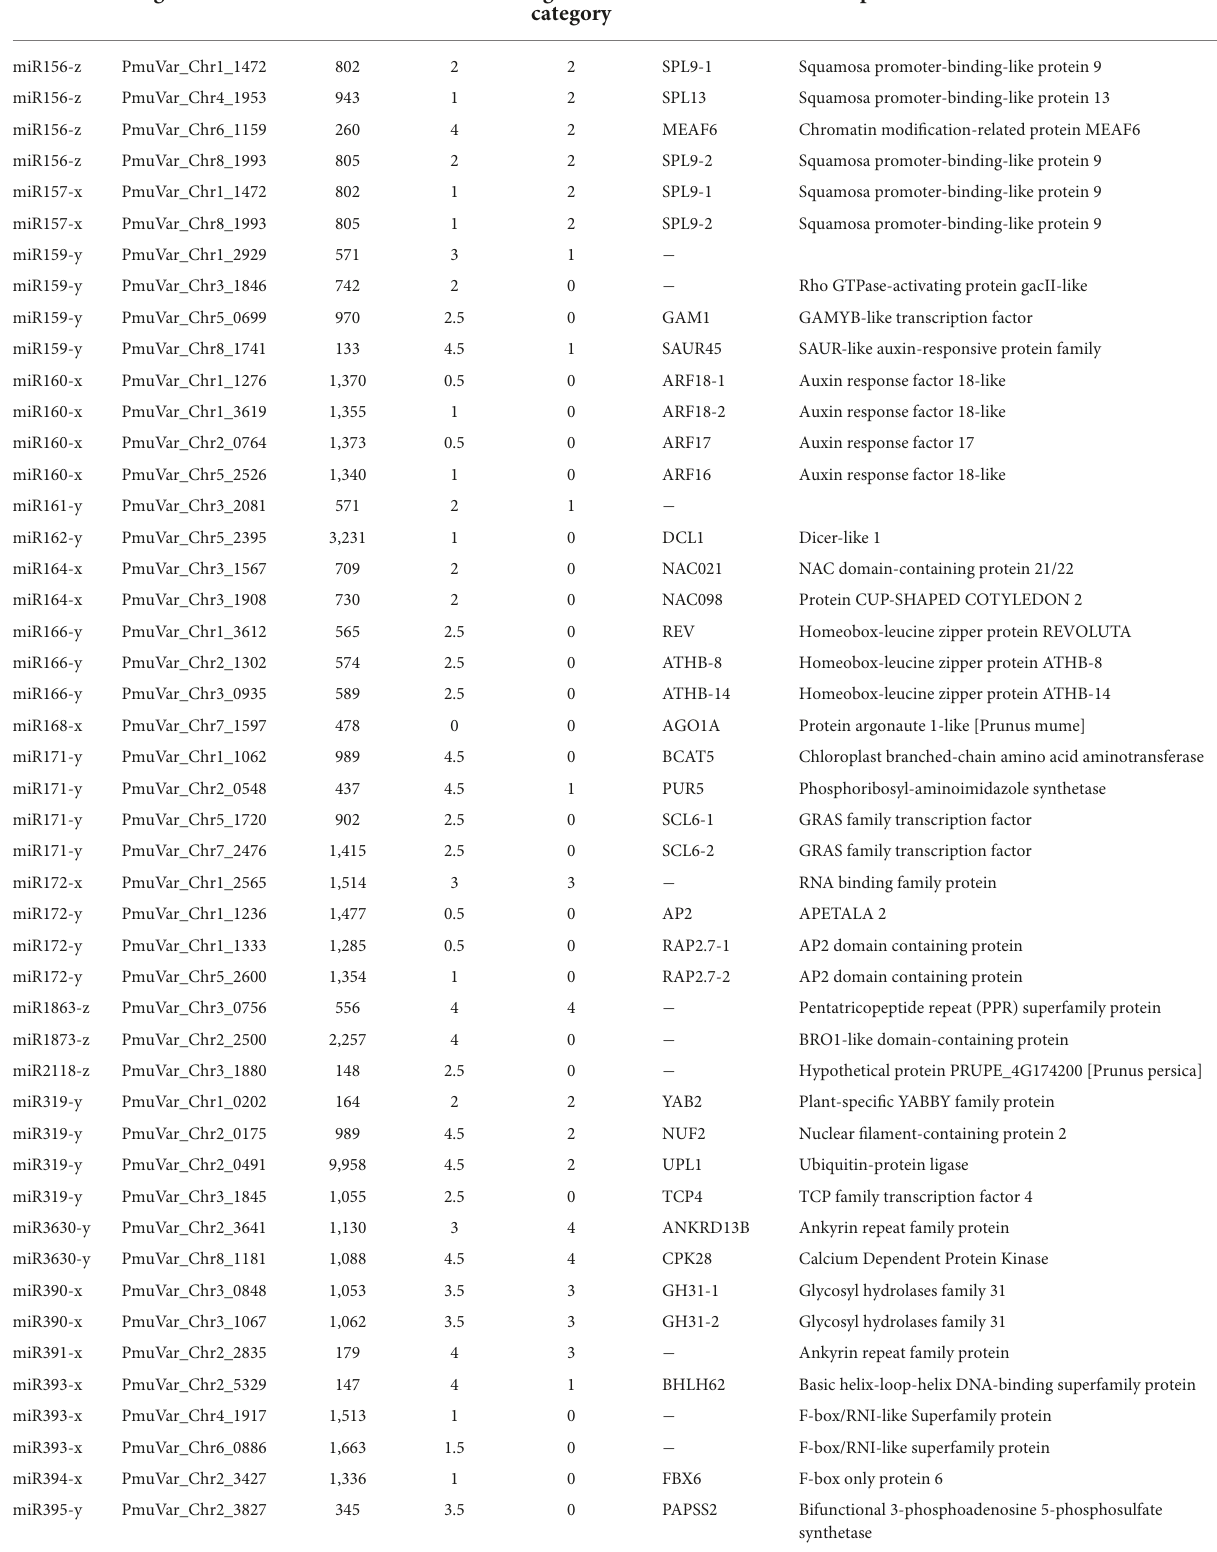
TABLE 3 Target genes of known miRNAs validated with degradome sequencing.